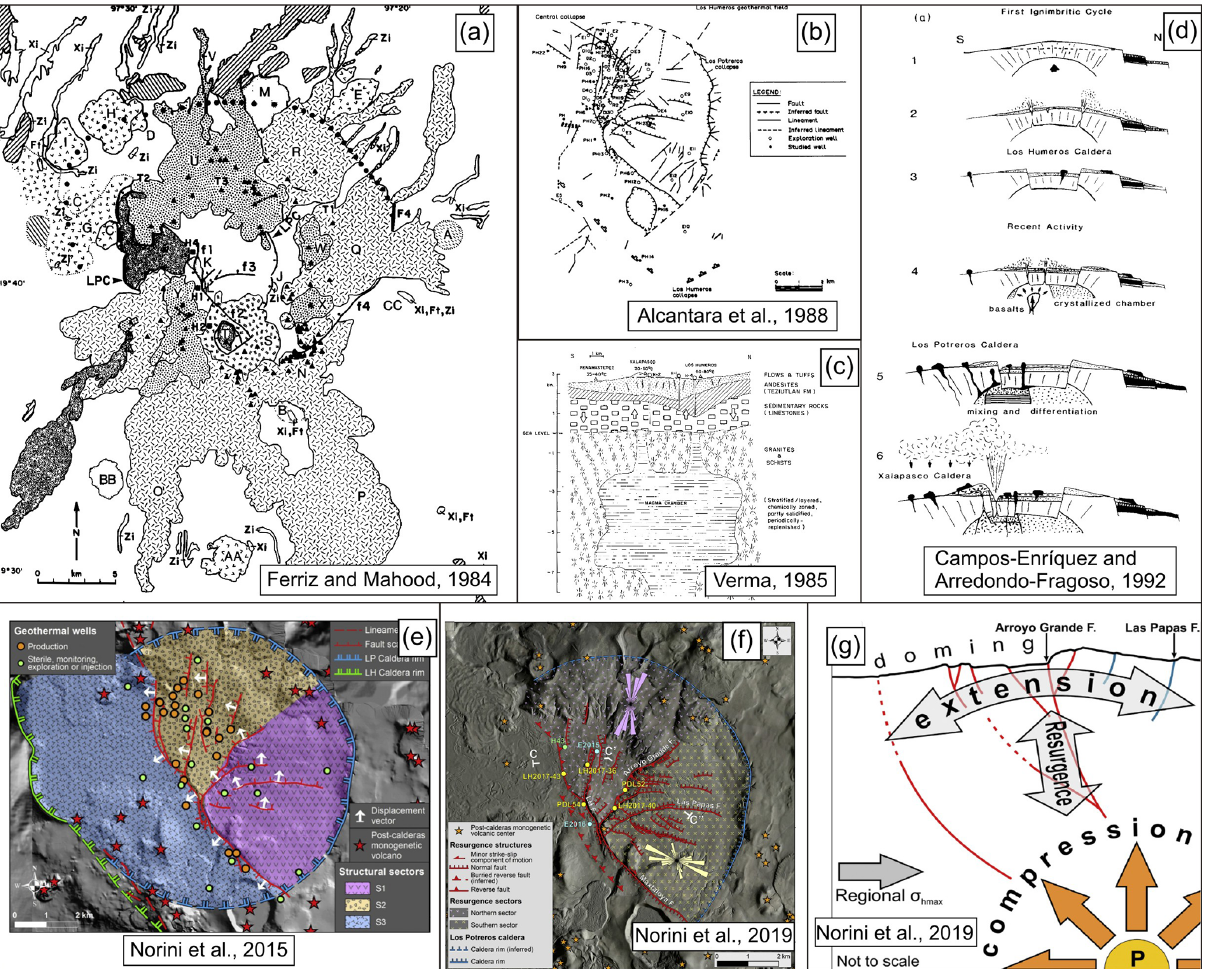
Figure 6. (a) The simplified geological map of the Los Humeros volcanic centre as proposed by Ferriz and Mahood (1984). (b) Schematic map of the Los Potreros caldera showing the main structures and the exploration wells drilled before 1988. This map was presented by Alcantara et al. (1988) based on an unpublished map by the Comisión Federal de Electricidad (CFE). (c) Conceptual model of the single voluminous magma chamber underlying the Los Humeros volcanic centre as proposed by Verma (1985). (d) Schematic representation of the evolution of Los Humeros volcanic complex by Campos-Enriquez and Arredondo-Fragoso (1992) where magmatism, eruptive styles, infla- tion and deflation phenomena are all correlated to the activity of the single voluminous and shallow-seated magma chamber of Verma (1985). (e) Morphostructural map of the Los Potreros caldera with interpretation of the sectorial resurgence as proposed by Norini et al. (2015). (f) Morphostructural map of the Los Potreros caldera with interpretation of the sectorial resurgence as proposed by Norini et al. (2019). (g) Schematic, not to scale, structural interpretation of the post-caldera resurgence at Los Humeros induced by a unique pressure source at depth as proposed by Norini et al.